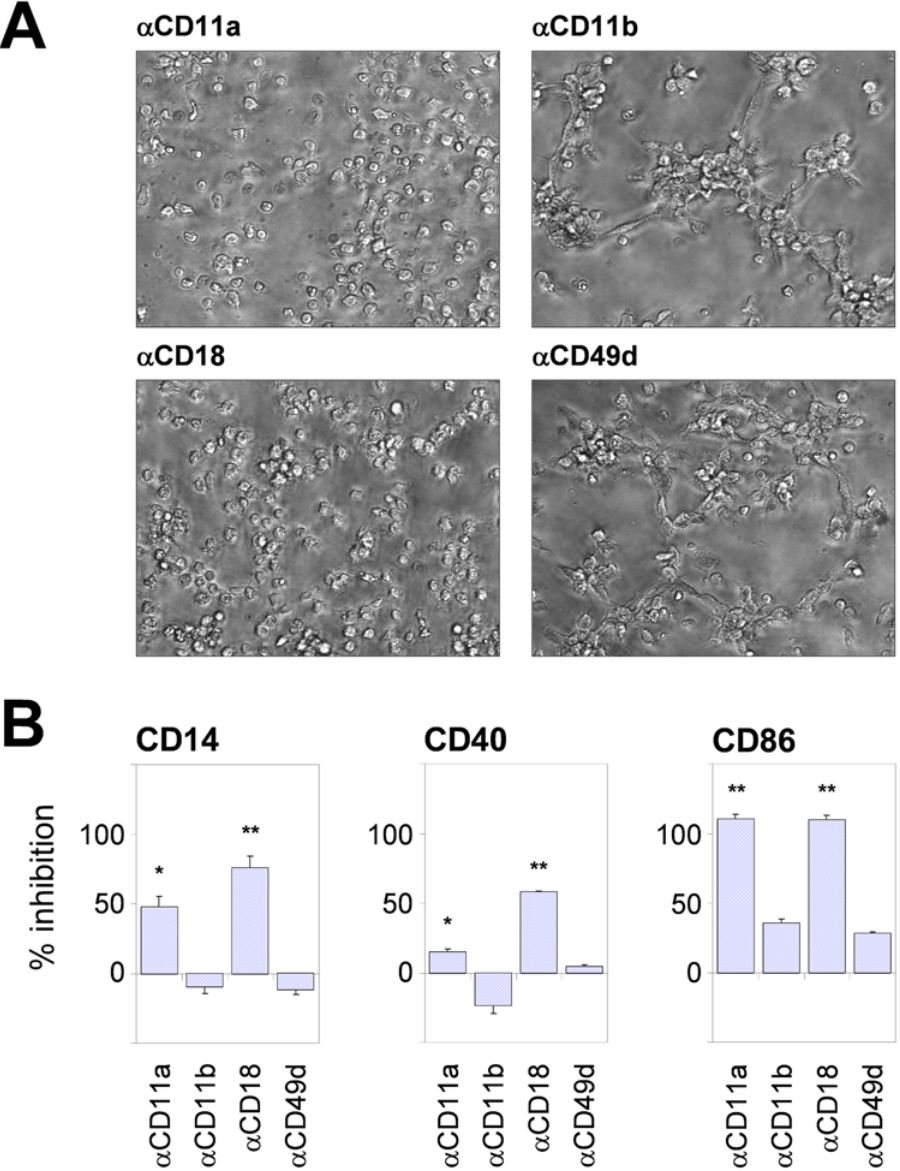
Figure 3. Monocyte- cd T cell crosstalk depends on cell-cell contract. ( A ) Microscopic analysis of co-cultures of monocytes and cd T cells incubated for 18 hours in the presence of HMB-PP and the neutralizing antibodies indicated. Data shown are representative of two individual donors. ( B ) Mean inhibitory effect 6 SEM of blocking antibodies on CD14 down-regulation, and CD40 and CD86 up-regulation. 0%, monocyte- cd T cell co- cultures with HMB-PP in the absence of blocking antibodies; 100%, monocytes cultured in medium only ( n =4–5).